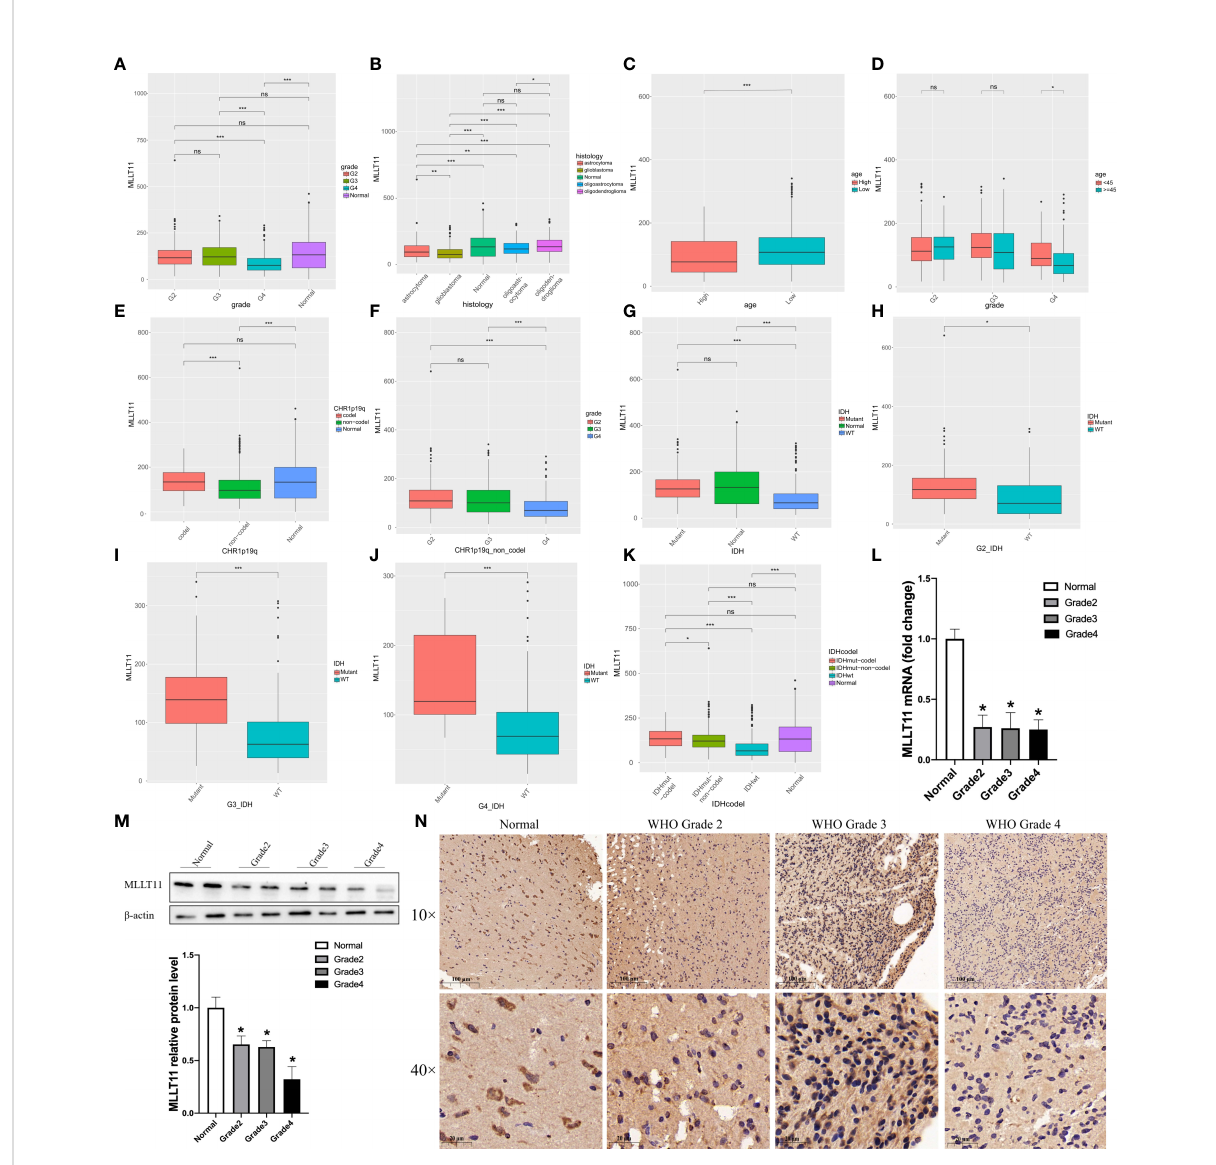
FIGURE 1 Clinical and molecular characteristics of MLLT11 in gliomas. (A, B) The expression of MLLT11 in different WHO pathological grades. (C, D) The expression of MLLT11 strati fi ed by age and WHO pathological grades. (E, F) The expression of MLLT11 in 1p19q codeletion and non-codeletion glioma. (G – J) The expression of MLLT11 in IDH mutant and wild type and strati fi ed by age and different WHO pathological grades. (K) The expression of MLLT11 in IDH mutation combined with 1p/19q codeletion and IDH mutation combined with 1p/19q non-codeletion. (L, M) Representative images of qPCR and Western blotting for MLLT11 in normal brain tissue and different tumor grades. (N) Representative images of IHC staining for MLLT11 in normal brain tissue and different WHO pathological grades of glioma. *p < 0.05, **p < 0.01, ***p < 0.001; ns, no statistics. G2, Grade 2; G3, Grade 3; G4, Grade 4; IDH, isocitrate dehydrogenase; WT,